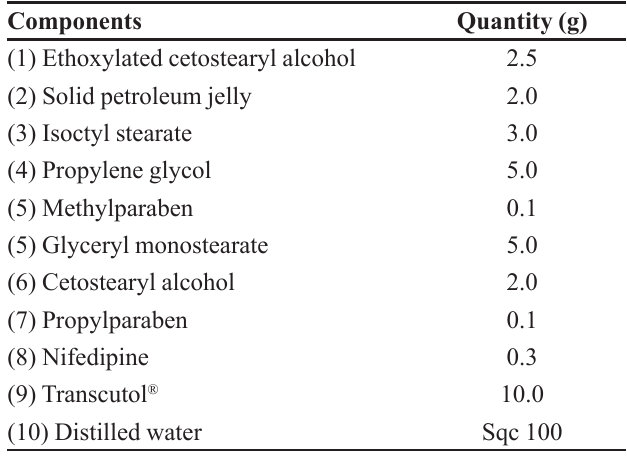
TABLE II - Components and preparation technique of the cream